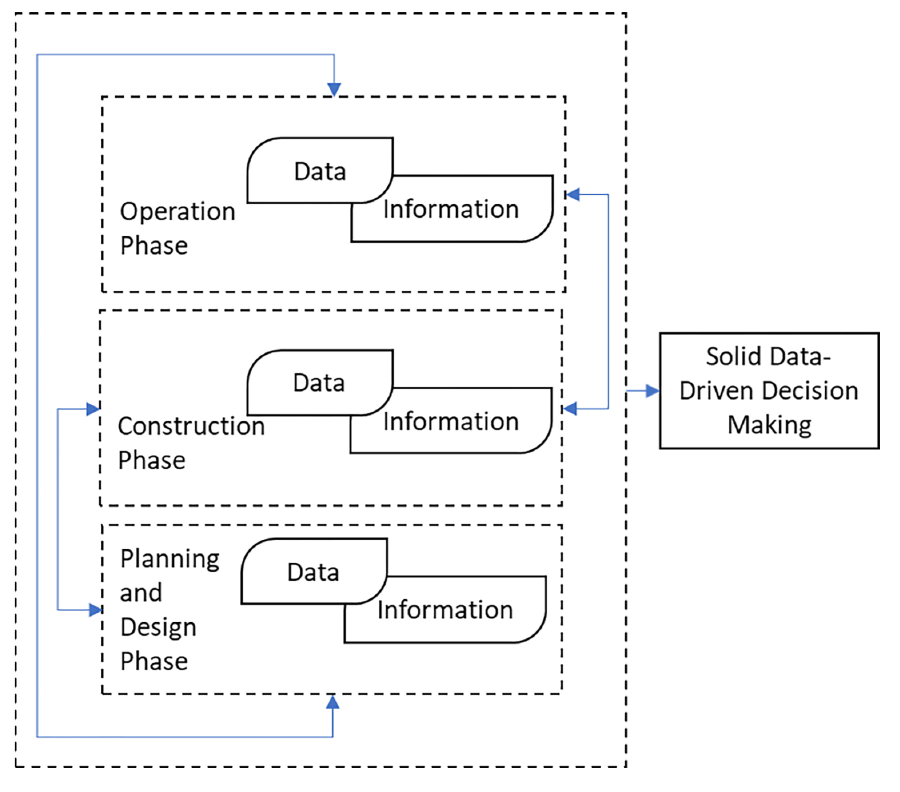
Figure 6. Project Data Information Decision